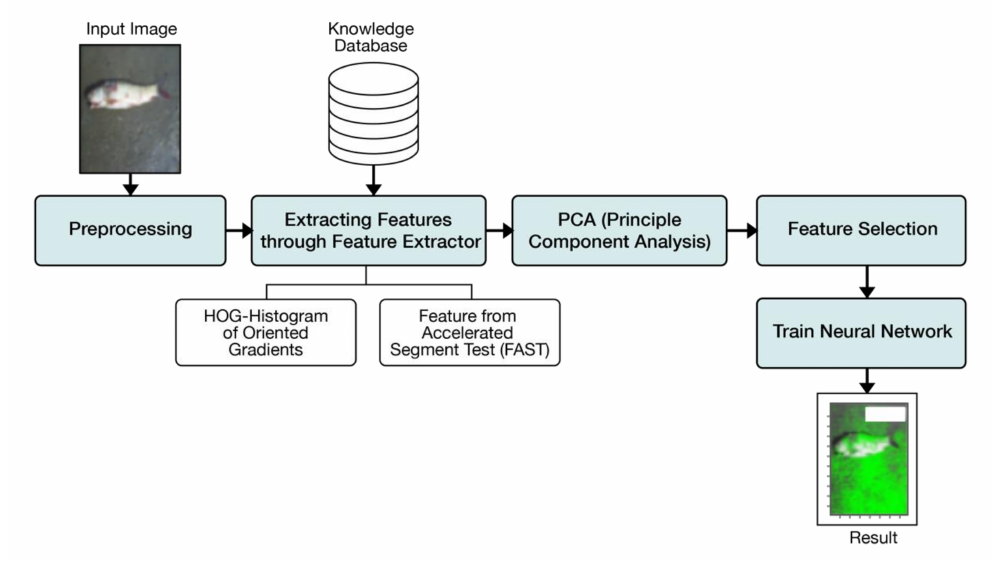
Figure 18. Proposed methodology.